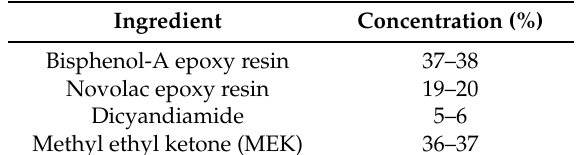
Table 1. Chemical composition of epoxy in carbon fiber-reinforced polymer (CFRP).